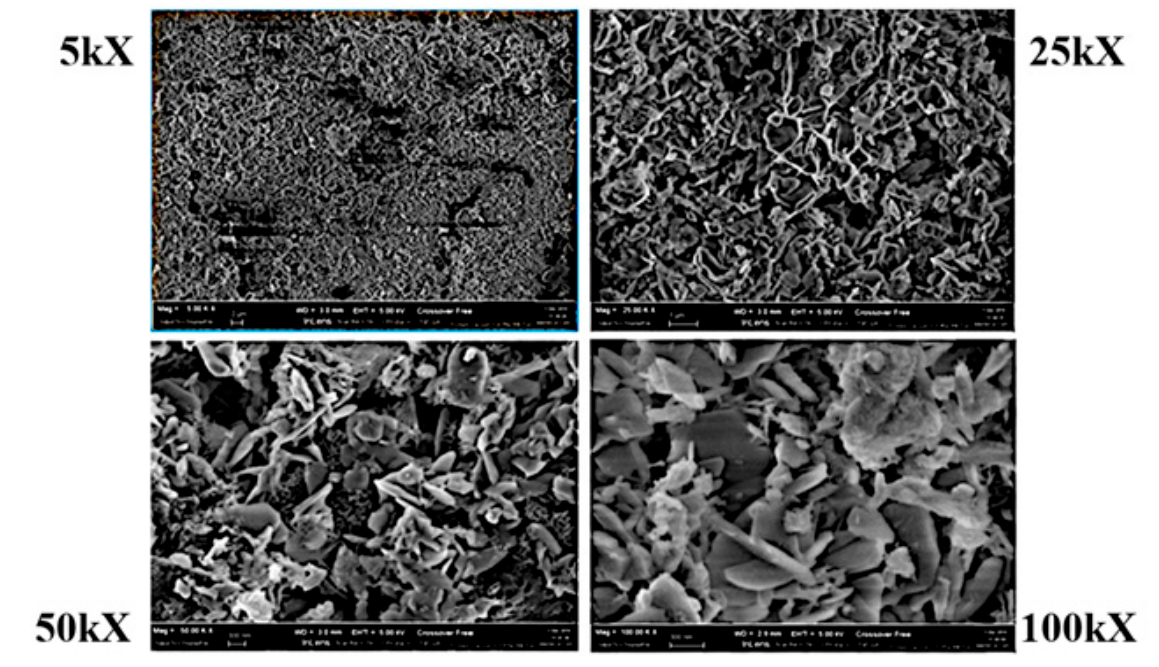
Figure 1. R8G SEM